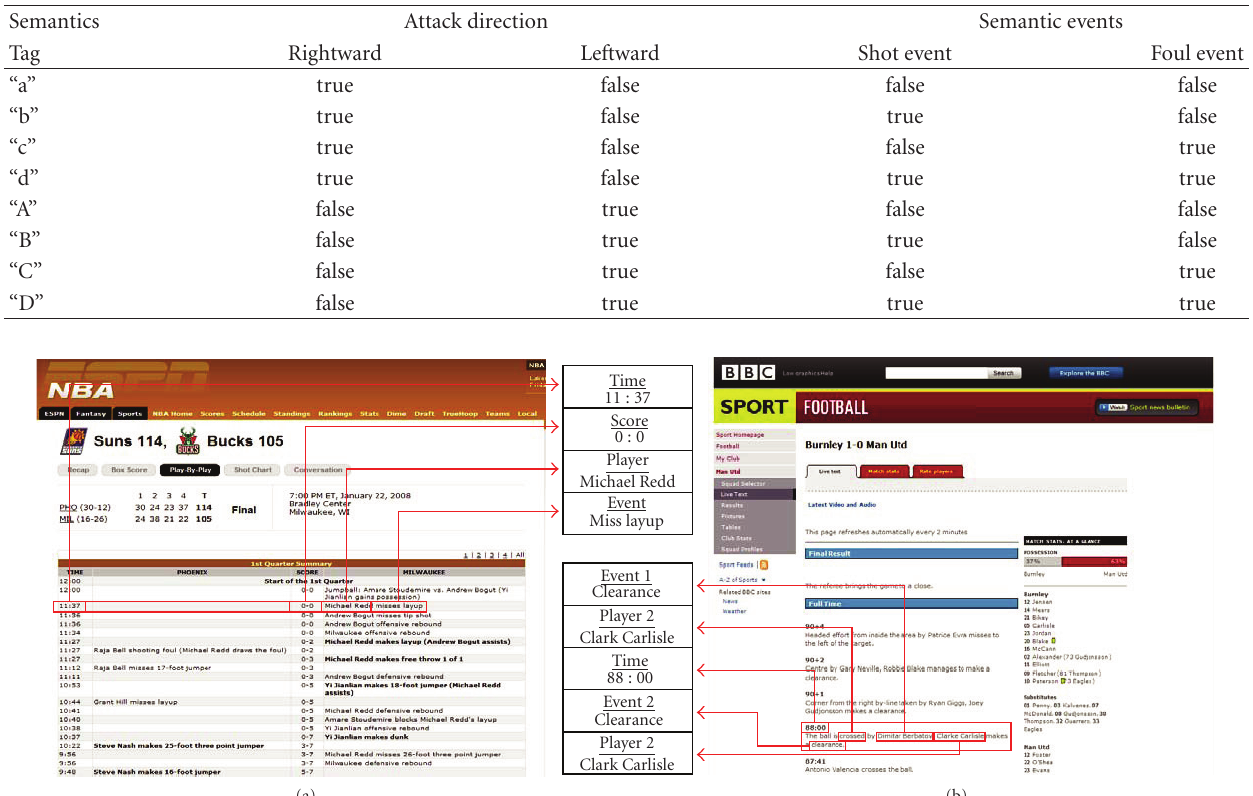
Table 1: Code book used for video tagging.